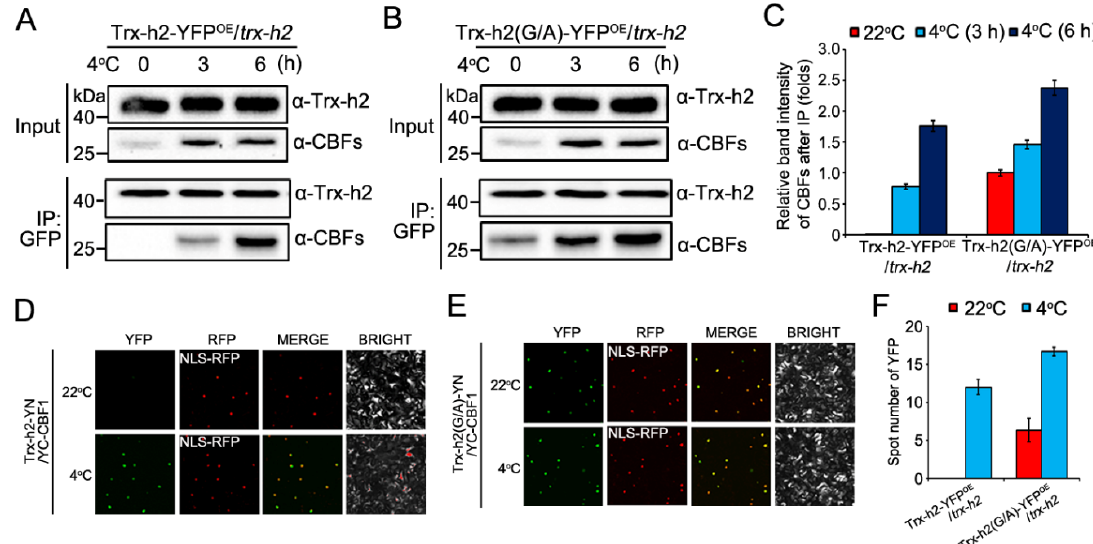
Figure 3. Comparison of the kinetics of nuclear translocation between Trx-h2 and Trx-h2(G/A), and of their interaction with CBFs at different temperatures. ( A , B ) Co-IP assay of Trx-h2-YFP and Trx-h2-YFP(G/A) proteins extracted from Trx-h2-YFP OE / trx-h2 ( A ) and Trx-h2(G/A)-YFP OE / trx-h2 ( B ) plants treated with cold stress at 4 ◦ C for the indicated duration. The immunoprecipitates were separated by SDS-PAGE and analyzed by Western blotting. ( C ) Quantitative analysis of the GFP band intensities in the bottom panels of ( A ) and ( B ) measured by densitometry and quantified by the ImageJ software. Interaction band intensity between Trx-h2 or Trx-h2(G/A) with CBFs was normalized by the immunoprecipitated level of Trx-h2(G/A) (in the first lane, bottom of panel ( B )). The Trx-h2(G/A)–CBF interaction intensity at 22 ◦ C, shown in the first lane in bottom panel ( B ), was set to 1. ( D , E ) BiFC assay performed by co-expressing Trx-h2-YN and YC-CBF1 ( D ) or Trx-h2(G/A)-YN and YC-CBF1 ( E ) in N. benthamiana leaves. Samples were incubated at 4 ◦ C and 22 ◦ C for 6 h. YFP signals analyzed by confocal microscopy were merged with the NLS-RFP signal (nuclear marker). ( F ) The YFP fluorescent-spots in panels ( D , E ) were counted and compared. Data represent mean ± s.e.m. ( n = 3 biologically independent